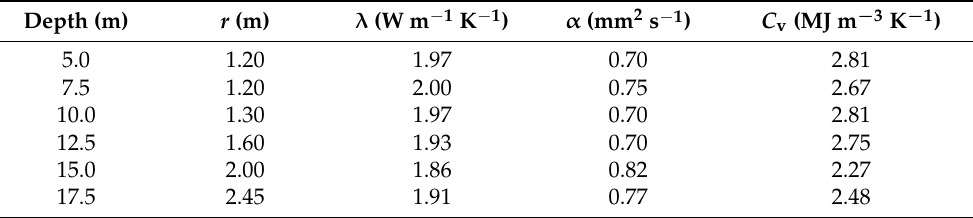
Table 2. Thermal diffusivity values used to match the observed data shown in Figure 7 and heat capacity inferred with thermal conductivity values reported in Table 1.